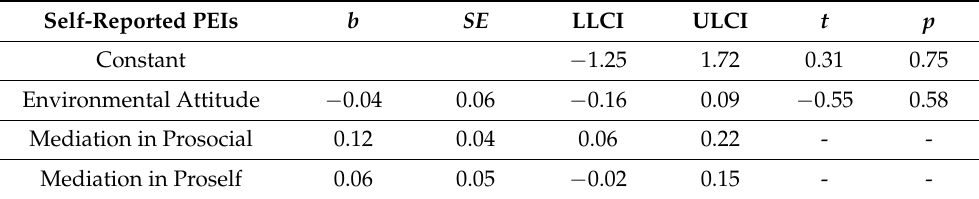
Table 2. Moderated Mediation Model of